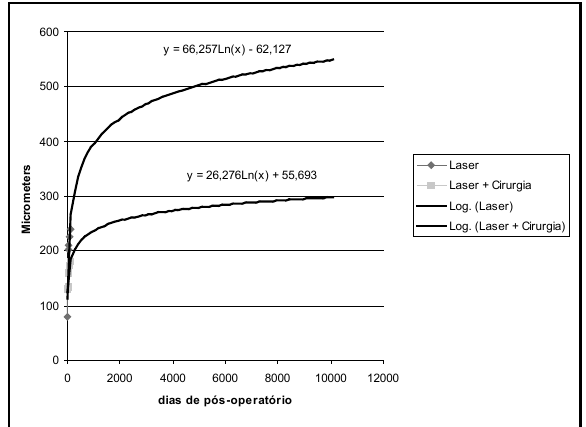
Figura 2 – Análise logarítmica da suposta tendência de crescimento das curvas de espessura da fibroplasia (no eixo Y) nos grupos EI ( laser ) e EII ( laser e cirurgia de lifting ) quando se extrapola o tempo de pós-operatório para 12.000 dias (eixo X)